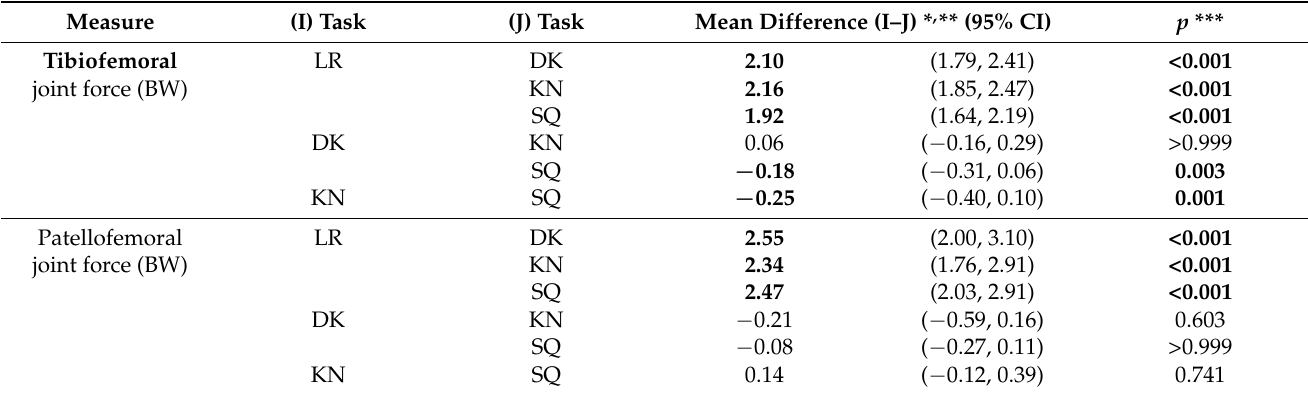
Table 2. Pairwise comparisons of the max knee joint forces between the different activities and postures (LR: lowering/rising; DK: deep kneeling; KN: kneeling; SQ: